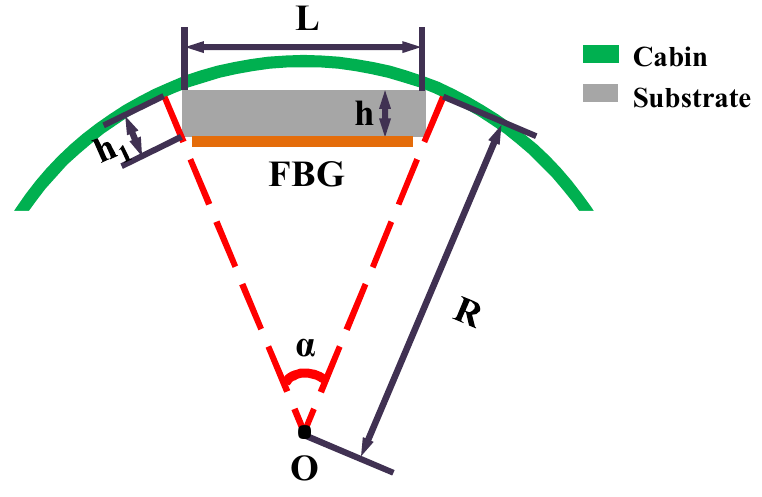
Figure 5. The top view of cabin pasted with the FBG sensor.